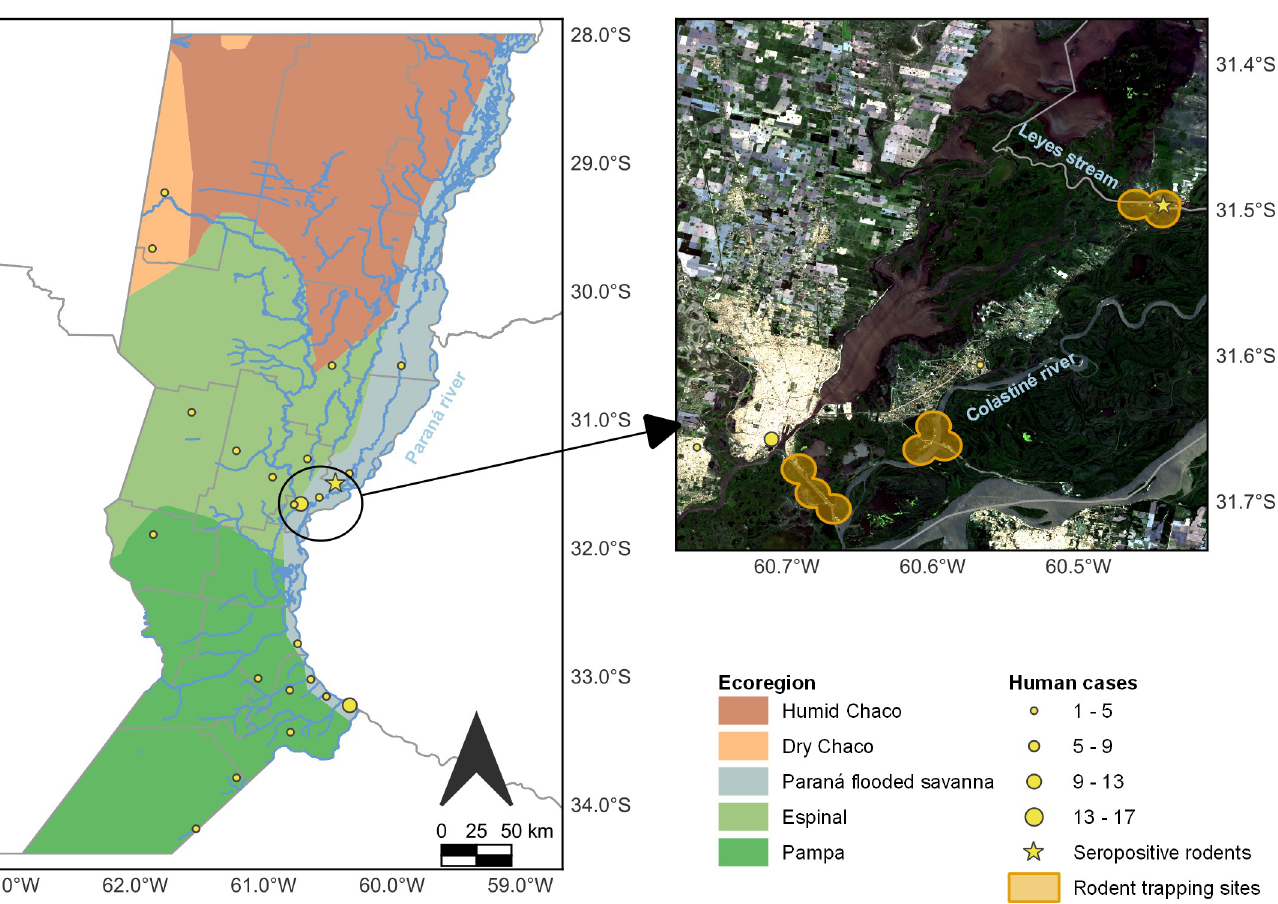
Fig 1. Hantavirus Pulmonary Syndrome cases distribution in the province of Santa Fe, Argentina, from 1996 to 2020. The small map displays a zoomed view of the city of Santa Fe and the 3 riverside communities where the rodent sampling was conducted (Sep. 2014- Oct. 2015). Map created using QGIS 3.14 Pi (QGIS Development Team). Vector layers: ecoregions polygon downloaded from Biodiversity Information System of the National Parks Administration, Argentina (SIB), provinces, departments, localities and water courses downloaded from National Geographic Institute (IGN). Base map: Landsat8 OLI/TIRS satellite imagery acquired from U.S. Geological Survey. LandSat 8 OLI/TIRS imagery acquired from US Geological Survey (https://earthexplorer.usgs.gov/) Licensing information: https://www.ign.gob.ar/descargas/tyc3.html; https://www.usgs.gov/centers/eros/science/usgs-eros-archive-data-use-and-citation?qt-science_center_objects=0#qt-